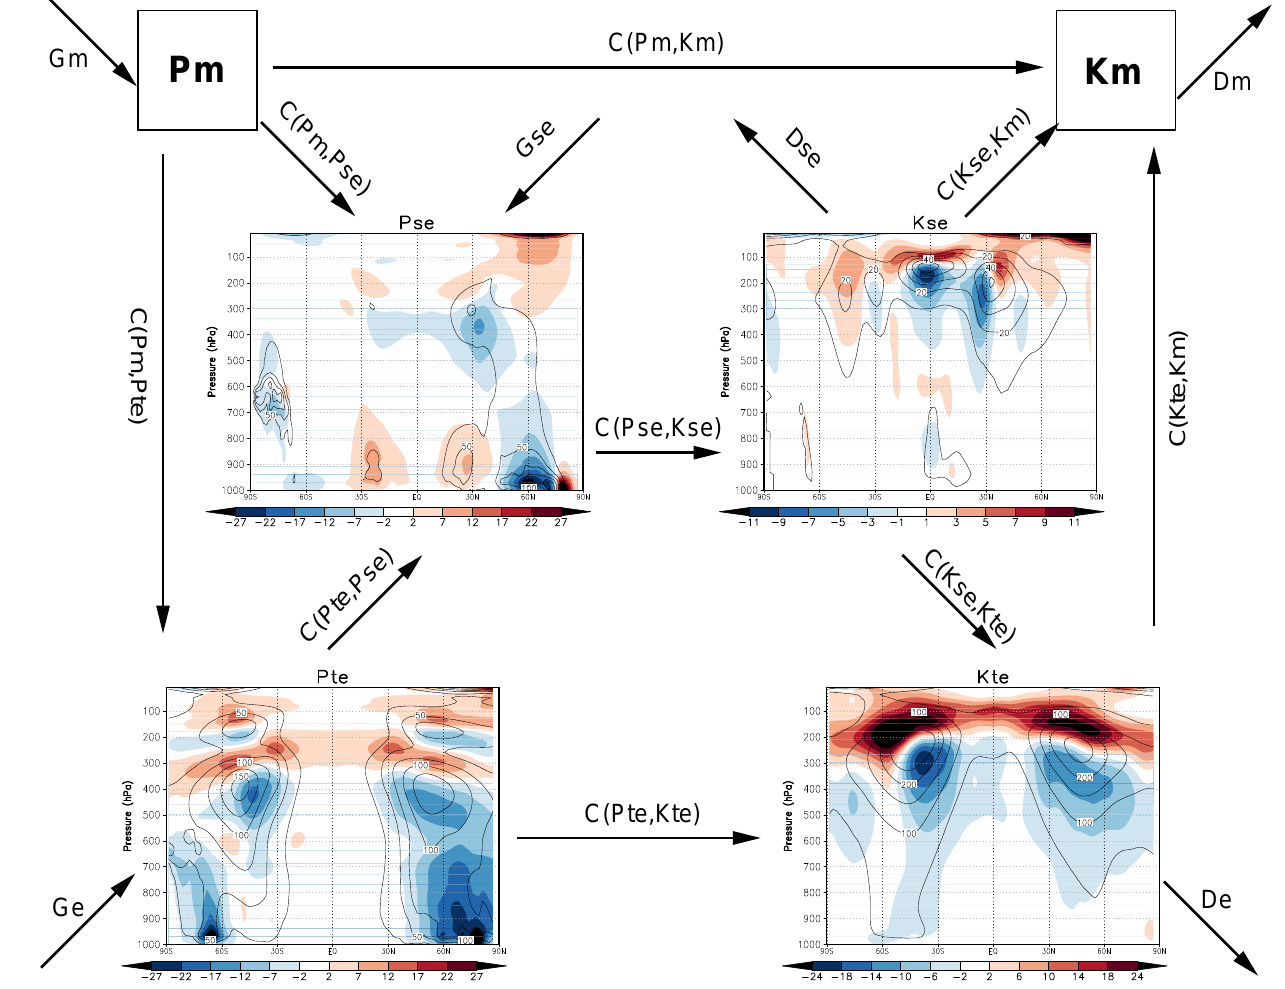
Fig. 6. Vertical cross sections of the stationary and transient eddy reservoirs ( P se , P te , K se and K te ) for the 1 × CO 2 control experiment (contours), and their 2 × CO 2 change (color shaded). Units are Jkg − 1